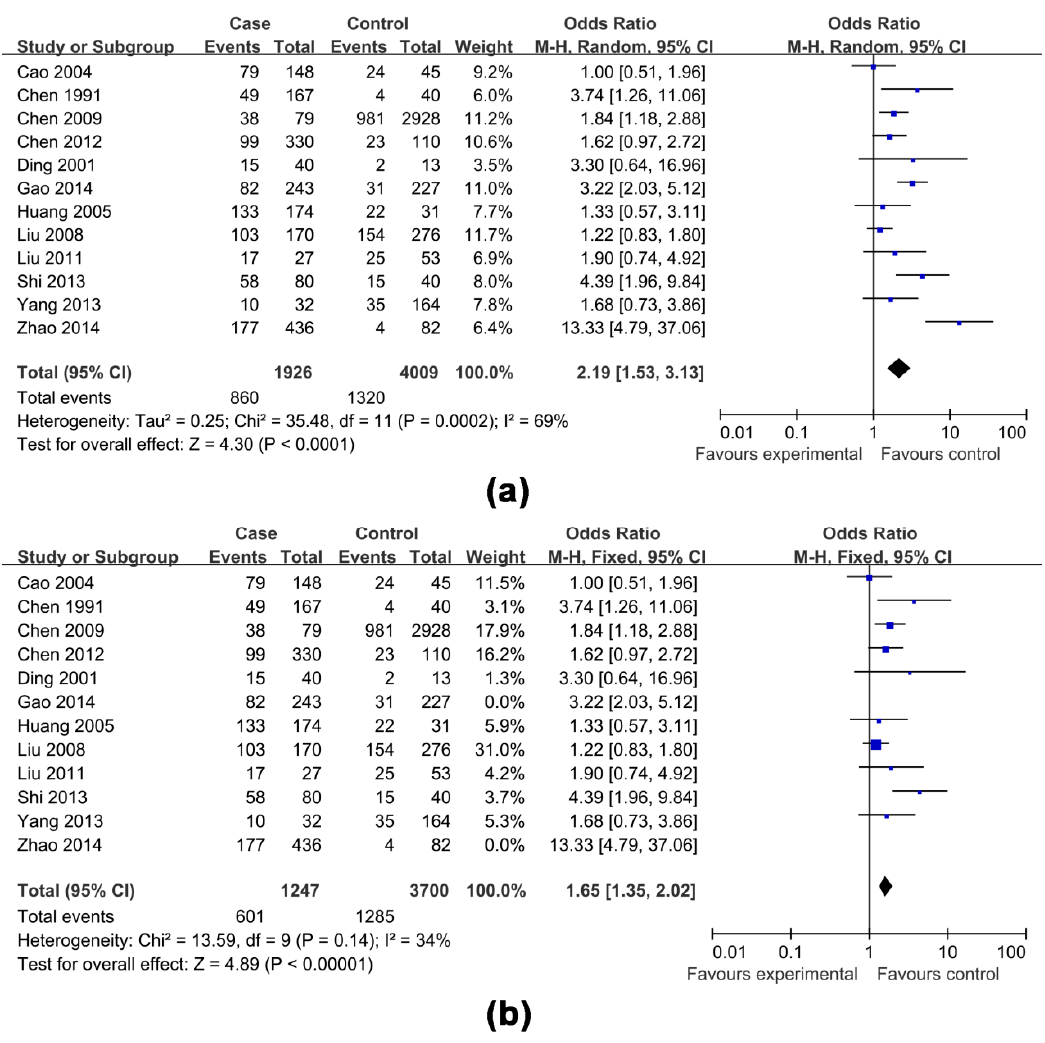
Figure 3. Effects of possible risk factors in chronic HBV-infected patients: ( a ) drinking alcohol; and ( b ) drinking alcohol adjusted.